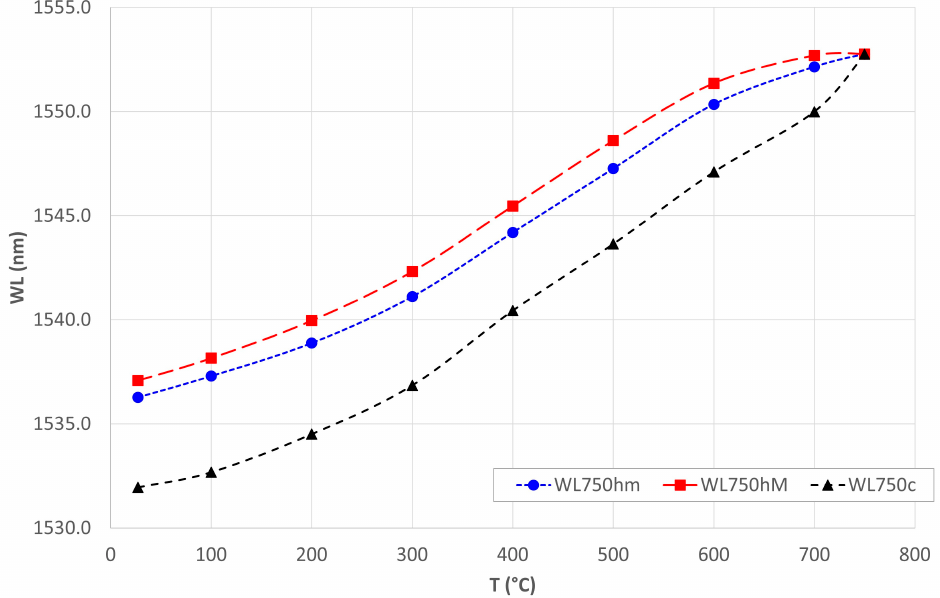
Figure 14. Spectrum’s peaks trend during thermal